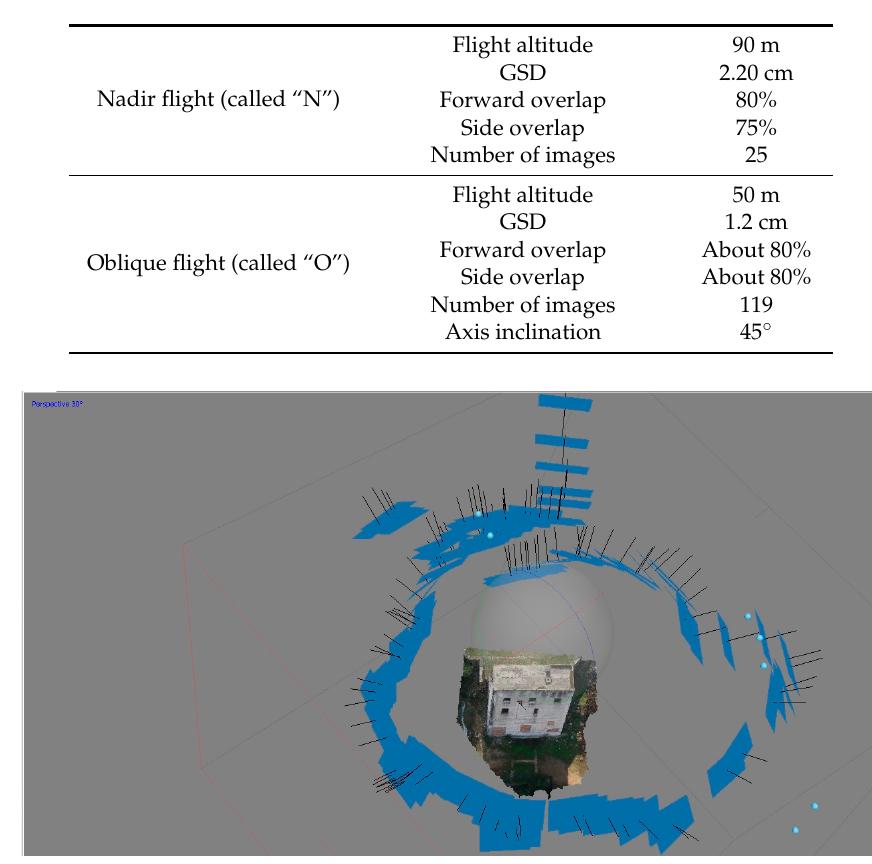
Table 8. Flight parameters.